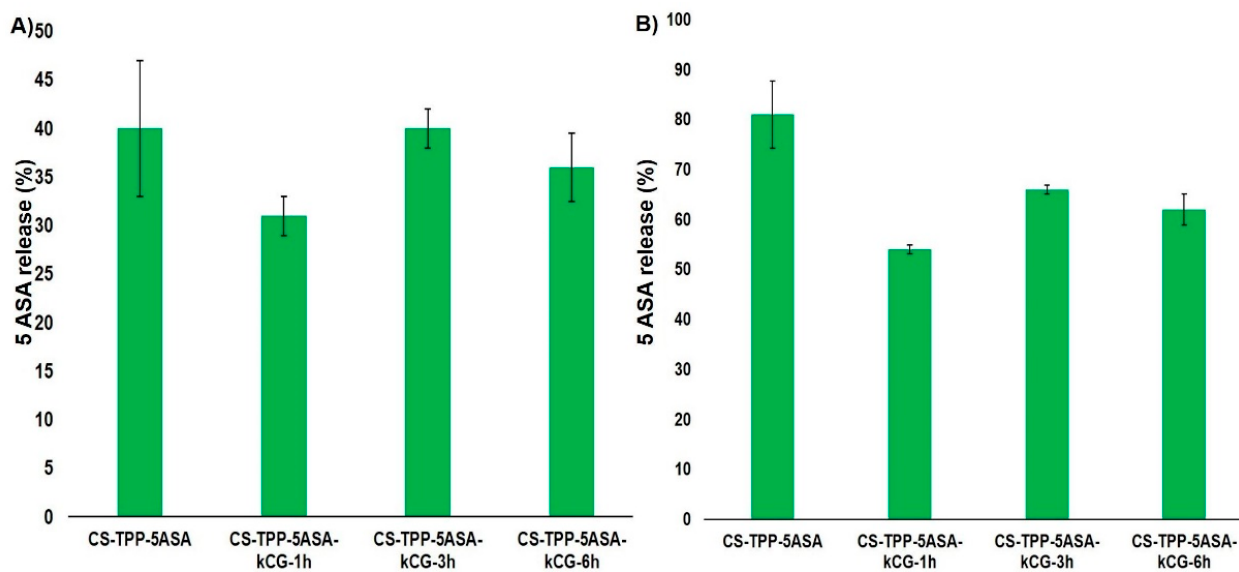
Figure 7. ( A ) Burst release at 15 min after immersion in SIF and ( B ) drug release from the hydrogel beads after 22 h in SIF at 37 °C.